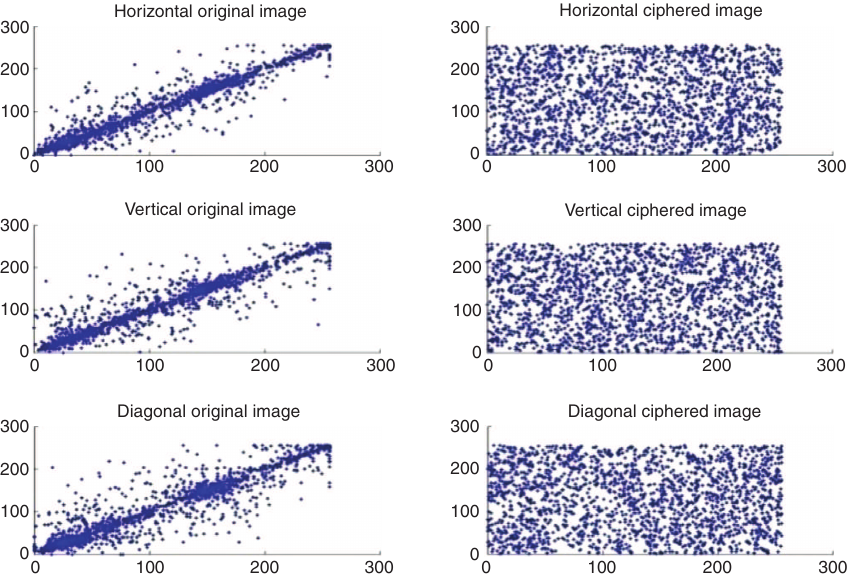
Figure 12: Correlation Horizontally, Vertically and Diagonally for Two Adjacent Pixels in Plain and Encrypted “Mona Lisa” Image.